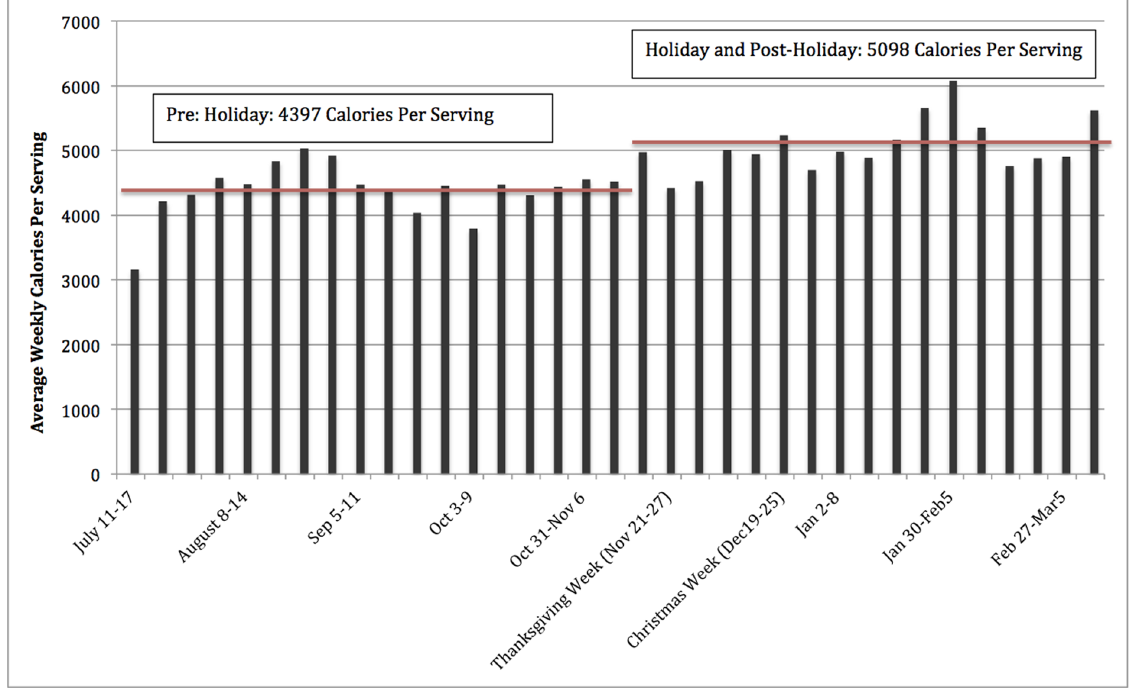
Figure 3. Households Purchase More Calories (per Serving per Shopping Trip) During the Holiday and Post-Holiday Seasons. Weekly average calories purchased were plotted out for the duration of the study. Thanksgiving fell on week 20 of the study and Christmas fell on week 24.